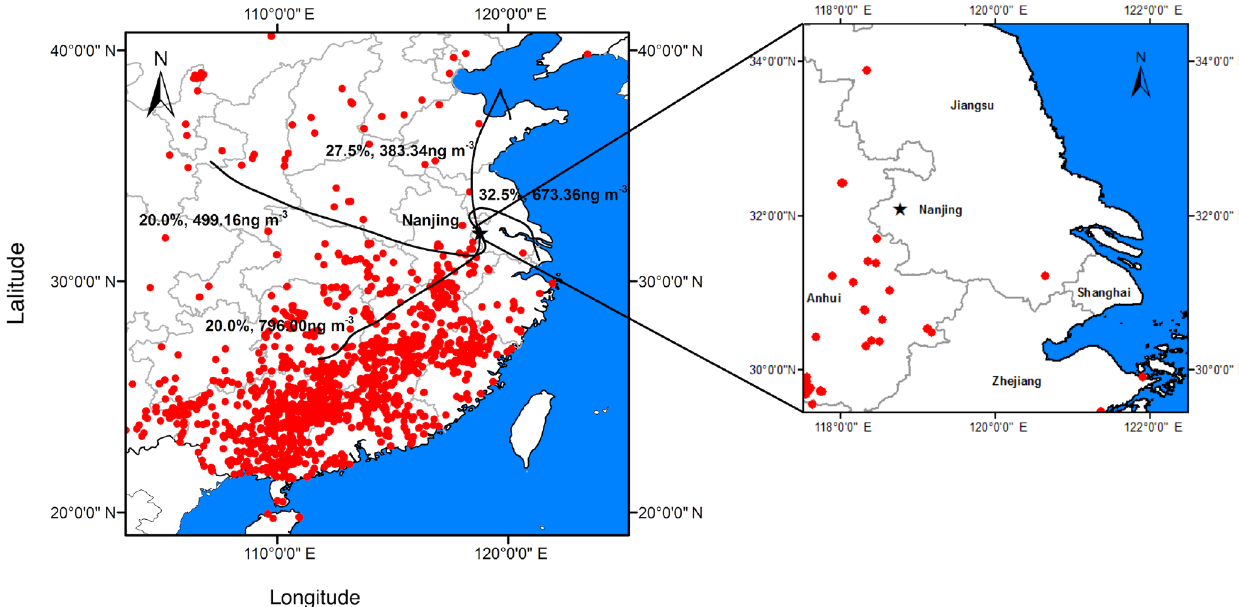
Figure 7. Air mass backward trajectory from 21 to 25 January, along with the MODIS fire spot map. Percentage refers to the air mass contribution to Nanjing and values with a unit of nanograms per cubic meter (ngm − 3 ) refers to the mean concentration of levoglucosan for every trajectory in that